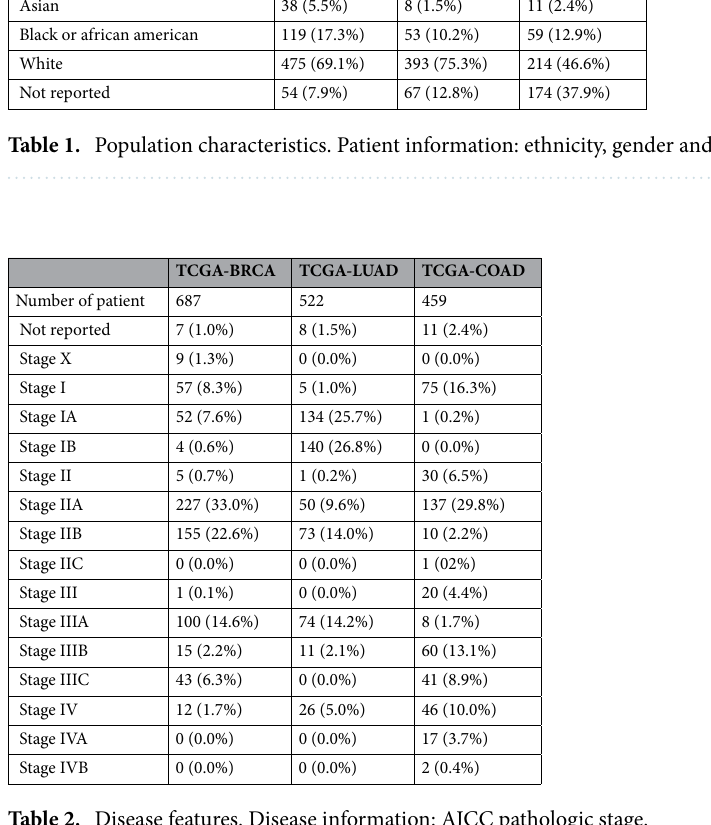
Table 2. Disease features. Disease information: AJCC pathologic